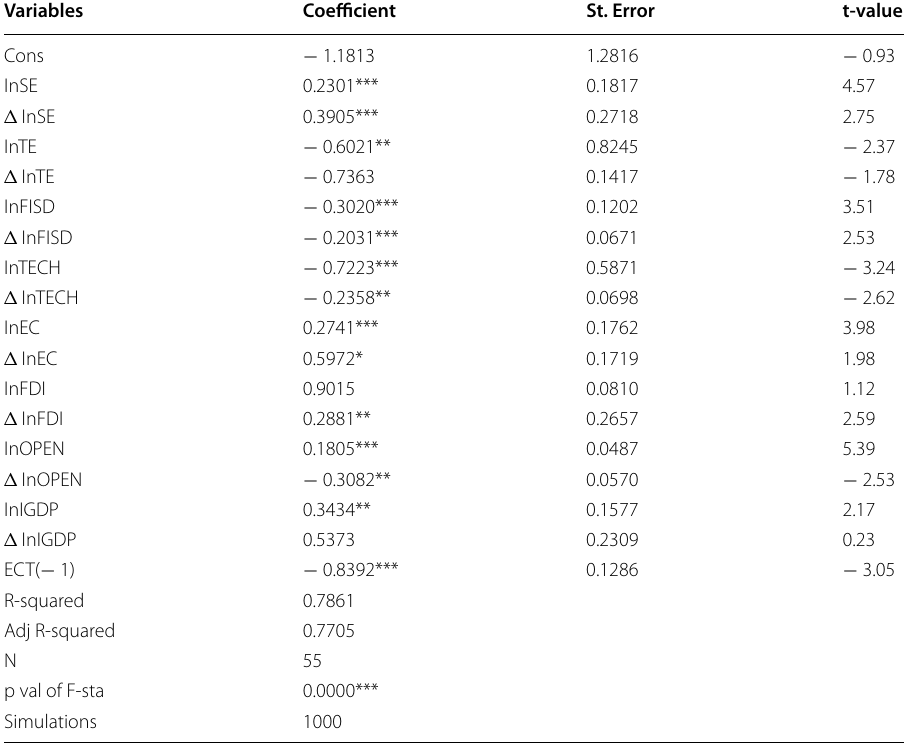
Table 8 Dynamic ARDL simulations